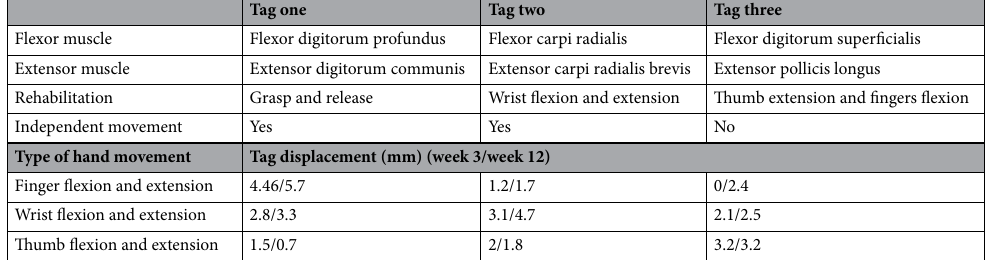
Rehabilitation game exercise by QG gesture detector algorithm. The patient performed a designed rehabilitation exercise, "Fist and Ball game", using the same prosthetic hand controlling QG algorithm in three easy, intermediate, and advanced levels. We ran the game two times in the laboratory, separated by one week. During this one-week interval, between the two tests, the patient repeatedly performed several tests him- self to rehabilitate. The repeated test results showed relative improvement in performance. The difficulty level (mode), ball speed, number of up and down movements during total running time, duration of time the patient held the ball, and the final score are presented in Table 3.